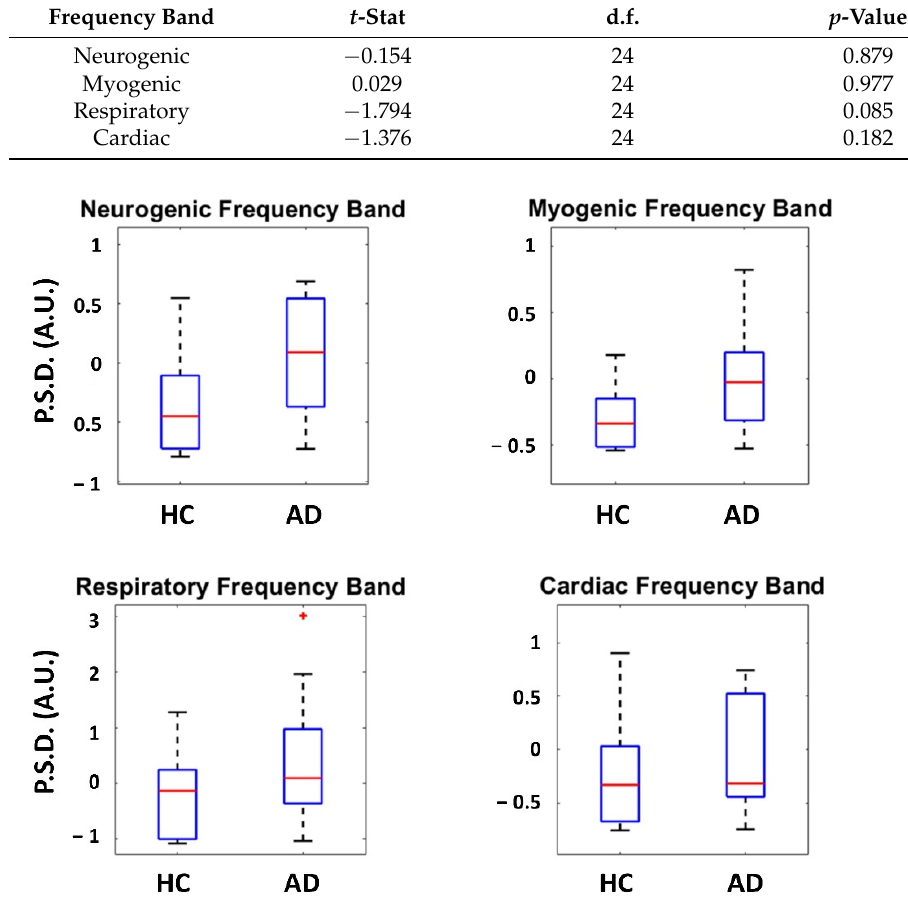
Figure 3. PSD evaluated in the considered frequency bands on the thermal signal collected from the nose tip. Each box shows the median and interquartile range, with the whiskers indicating the range of values. Data points beyond the whiskers are displayed as red ‘+’ in the figure.